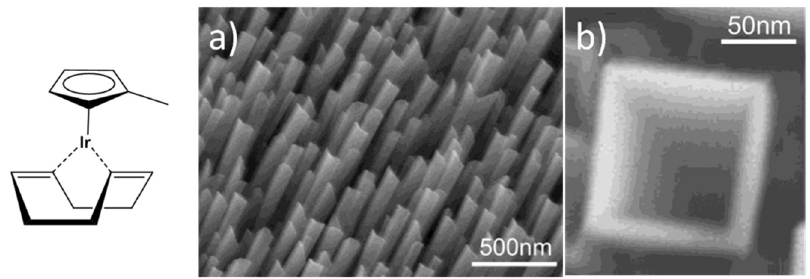
Figure 7. Chemical structure of [(MeCp)Ir(COD)] and SEM micrographs at different magnifications of IrO 2 nanotubes synthetized through MOCVD, ( a ) top view of IrO 2 nanotubes, ( b ) a wedge-shaped rod (Reprinted/adapted with permission from Ref. [103]).